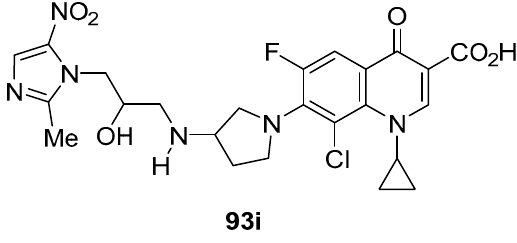
Figure 6. Structure of hybrid 93i.